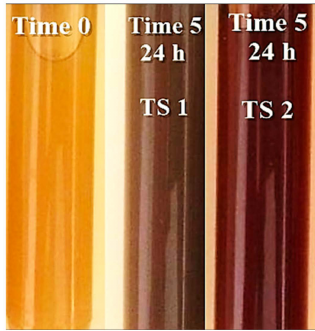
Figure 1. Color transformation of beech bark extract solution with AgNO 3 at pH = 4 (test solution 1 (TS1)) and pH = 9